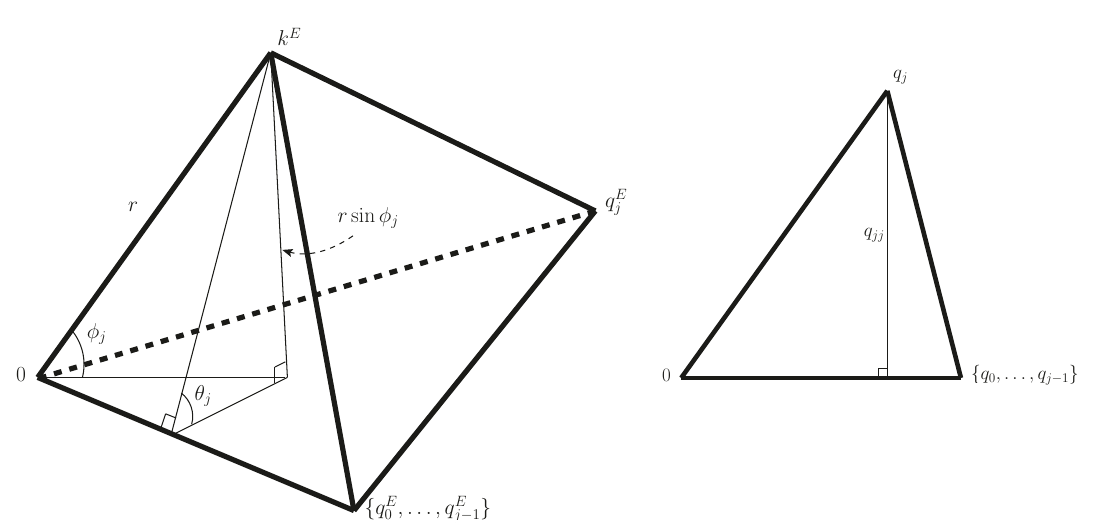
Figure 2 . The simplex are r sin (cid:30) j and q E